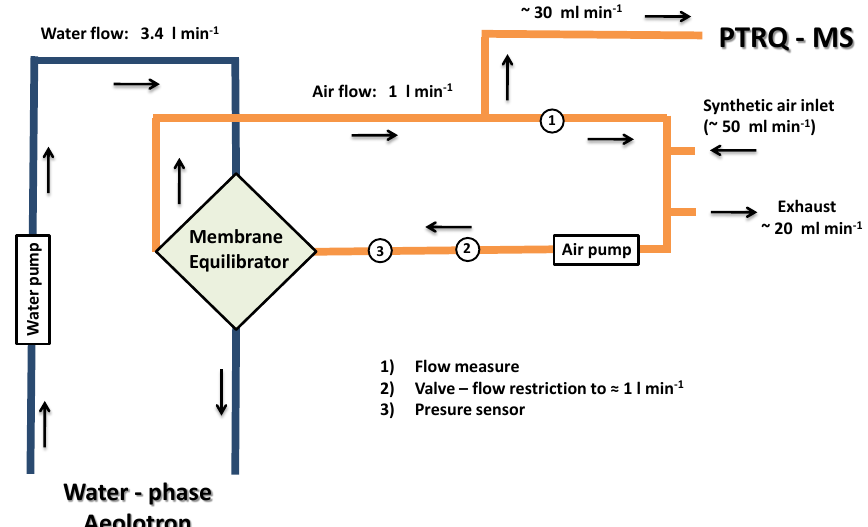
Figure 6. Membrane equilibrator – PTRQ-MS set-up schematic. The dark blue and orange lines represent the water and air loops of the system,